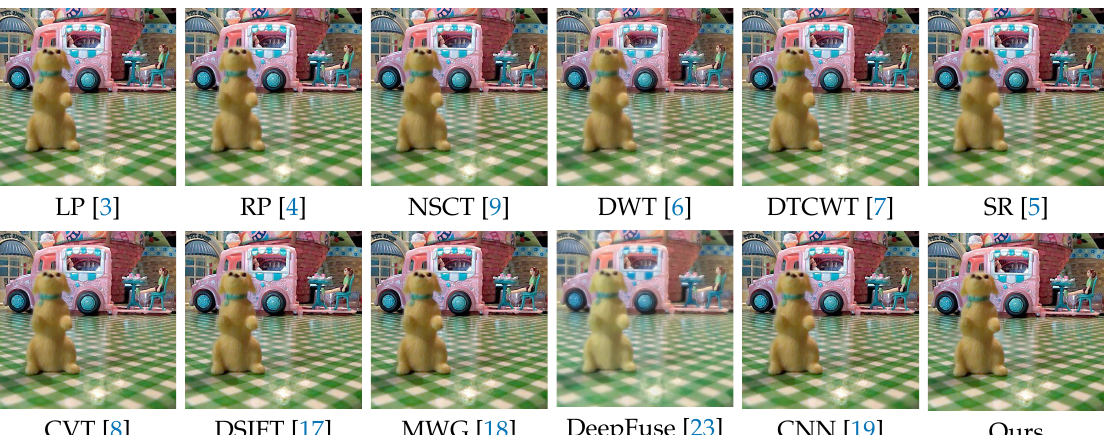
Figure 8. The fusion results of ’Lytro-17’ using various methods.